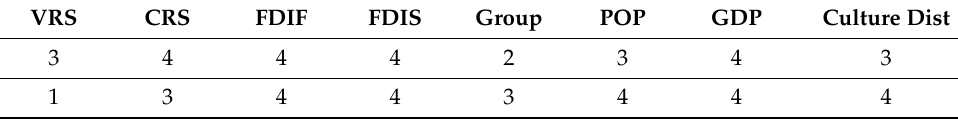
Table 4. Coding system of immune algorithm in key node analysis. VRS CRS FDIF FDIS Group POP